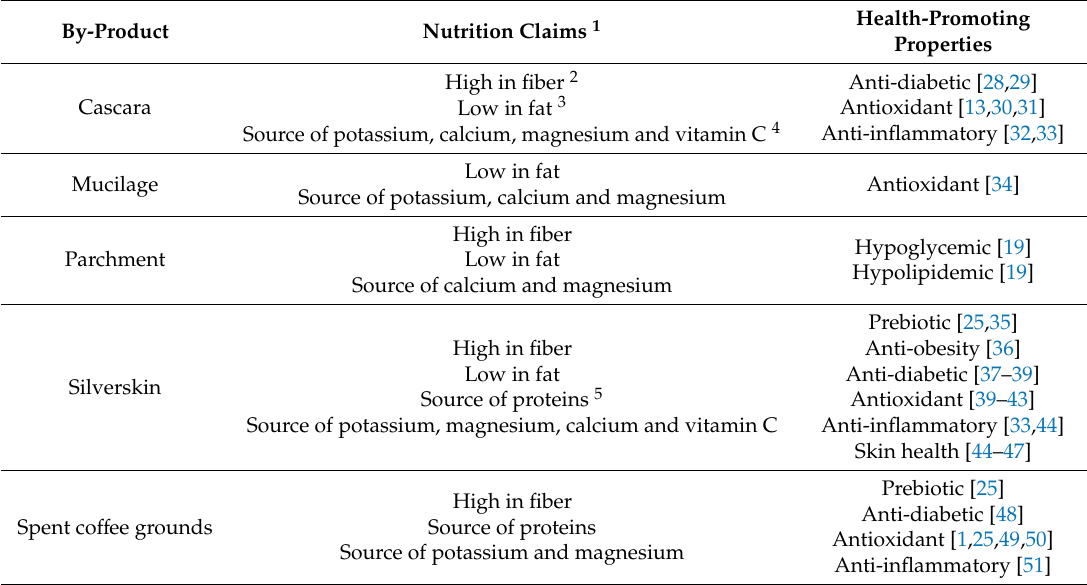
Table 2. Nutrition claims and health-promoting properties of co ff ee by-products associated with their composition that is shown in Table